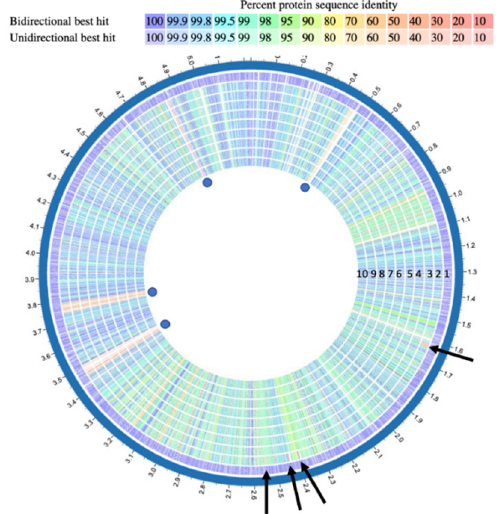
Figure 5. The chromosome-encoded proteins of ISS Bacillus isolates compared with those of B. an- thracis str. Ames. The B. anthracis str. Ames proteins, circle 1, are depicted in purple, this colour indicates 100% identity. Only a few regions of the ISS Bacillus strains are below the 60–70% of identity, in peach colour, compared with B. anthracis str. Ames, the phage regions absent in the ISS strains are marked with blue dots. The plot also shows the high identity of the ISS Bacillus proteins, with the exception of Bacillus ISSFR-23F strain, circle 2, which shows divergence in some protein regions, black arrows. The list of proteins lacking at least in one ISS Bacillus strain compared with B. anthracis str. Ames, are reported in Supplementary Table S2. Genomes, from outside to inside: circle 1: B. anthracis str. Ames (purple); circle 2: Bacillus sp. ISSFR-23F; circle 3: Bacillus sp. JEM-2; circle 4: Bacillus sp. ISSFR-9F; circle 5: Bacillus sp. JEM-1; circle 6: Bacillus sp. S1-R4H1-FB; circle 7: Bacillus sp. S2-R3J1-FB-BA1; circle 8: Bacillus sp. S1-R1J2-FB; circle 9: Bacillus sp. ISSFR-25F; circle 10: Bacillus sp. S1-R2T1-FB. Blue dots: phage regions absent in the ISS strains. Black arrows: regions of the Bacillus ISSFR-23F strain divergent from the other Bacillus ISS strains.